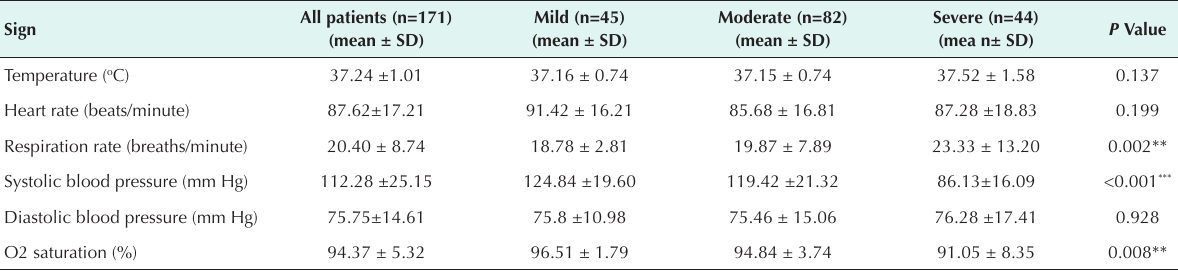
Table 4. The Association between Different Groups of Severity With Vital Signs and O2